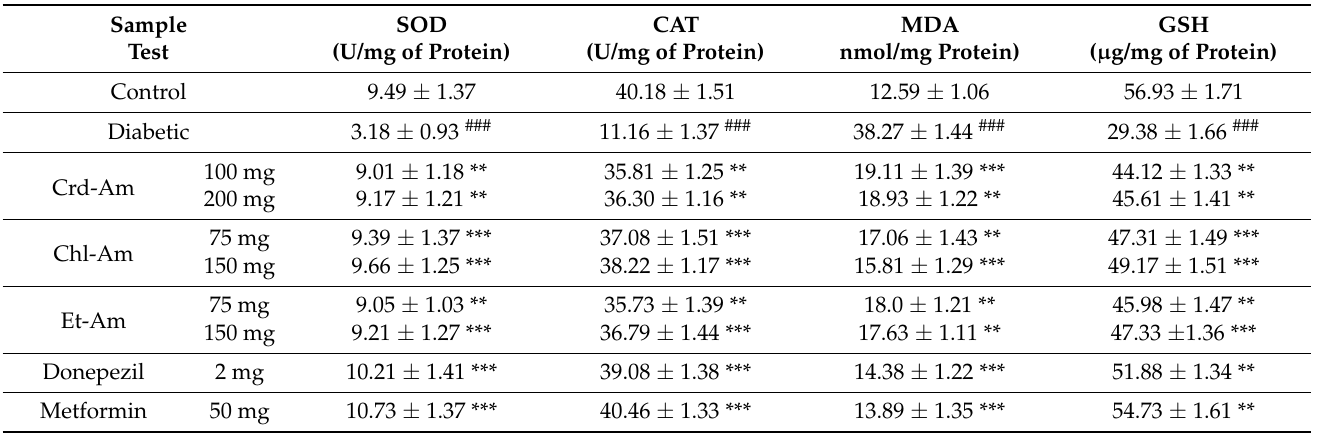
Table 5. Effects on biomarker levels in